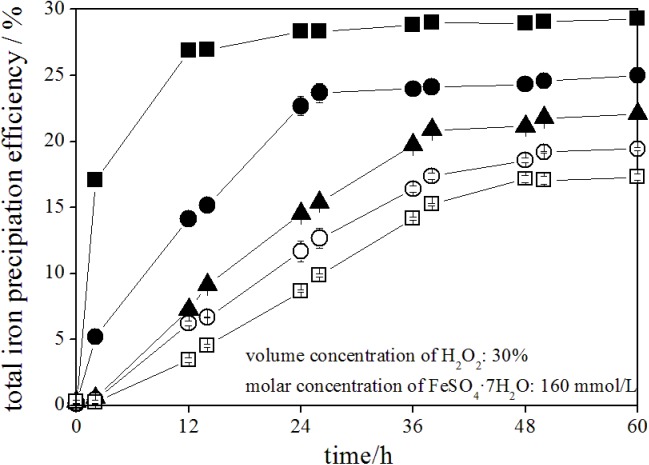
Variations in total Fe precipitation during ferrous ions chemical oxidation with H2O2 adding FeSO4·7H2O solution at different rates.150 mL of FeSO4·7H2O solution with addition of ■: 1.80 mL of H2O2 at 2 h (treatment 1); ●: 0.90 mL of H2O2 at 2 and 14 h (treatment 2); ▲: 0.60 mL of H2O2 at 2, 14, and 26 h (treatment 3); ○: 0.45 mL of H2O2 at 2, 14, 26, and 38 h (treatment 4); □: 0.36 mL of H2O2 at 2, 14, 26, 38, and 50 h (treatment 5).